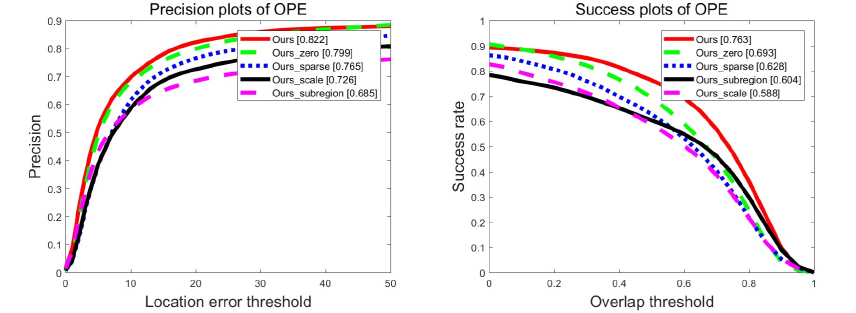
Figure 2. Precision and success plots of disabling component tracker on the OTB-2015 dataset for the ablation analysis. In this plot, Ours_subregion denotes Ours without using the subregion, and likewise Ours_scale, Ours_zero, and Ours_sparse denotes Ours without using scale estimation, zero-padding, and sparse constraint,